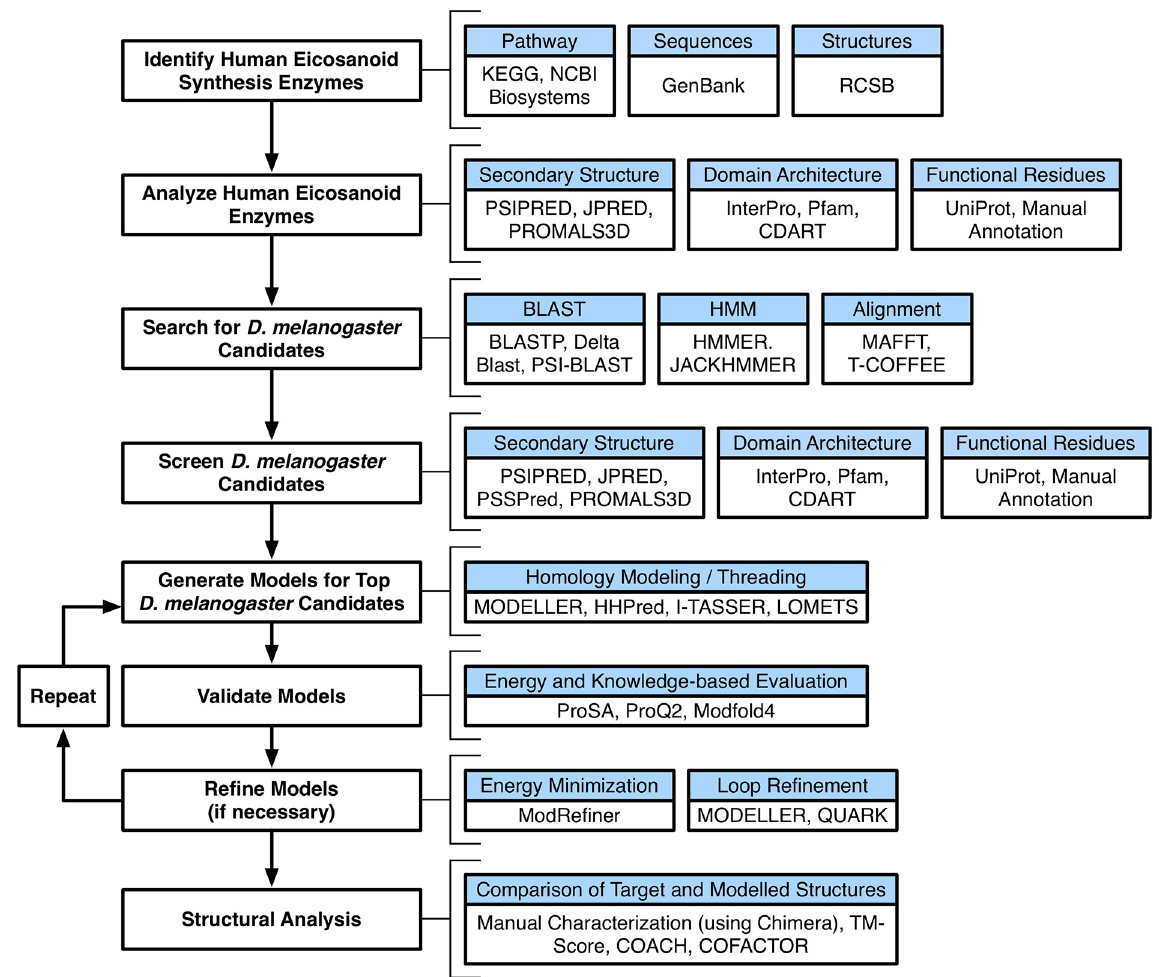
Fig 1. Summary of the workflow and tools used to carry out the present study. A schematic of the workflow devised to identify, model, and characterize various orthologs of the human eicosanoid pathway.